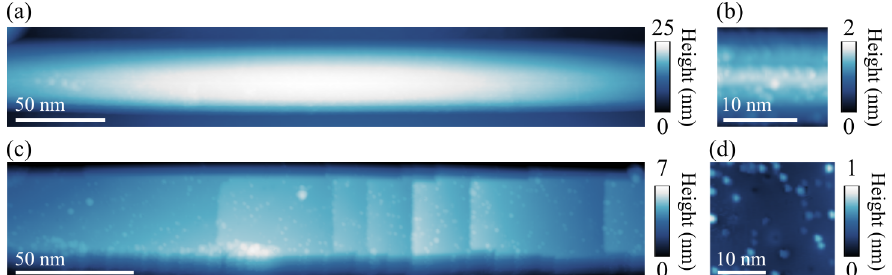
FIG. 5. (a) STM topography of a nanowire grown without faceting, exhibiting a round cross section. (b) Zoomed-in topography of (a). The round cross section, in conjugation with the lattice discretization, yields a corrugated stepped surface filled with randomly oriented dangling bonds. (c) A large-scale topography of a wide facet on top of a wire with multiple stacking faults (same as in Fig. 3). (d) Zoomed-in topography of one of the terraces. The average distance between impurities is a couple of nm.